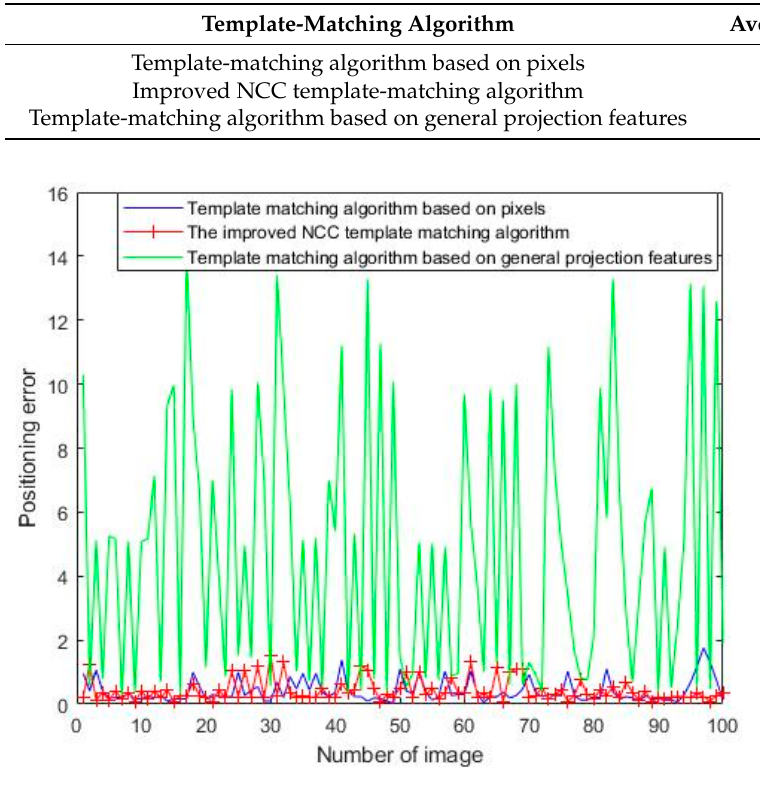
Figure 10. Positioning error comparison of three template-matching algorithms. Table 1. Operating time comparison of three template-matching algorithms.